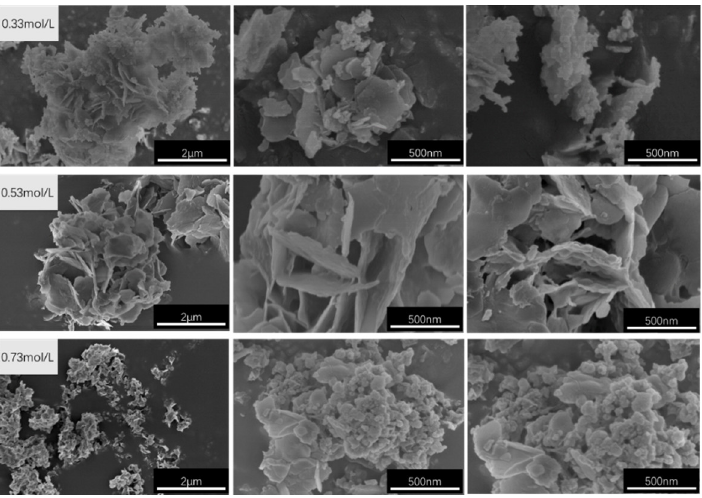
Figure 12. SEM images of CaAl–SiO 3 –LDHs samples prepared at different Ca 2+ molar concentrations.